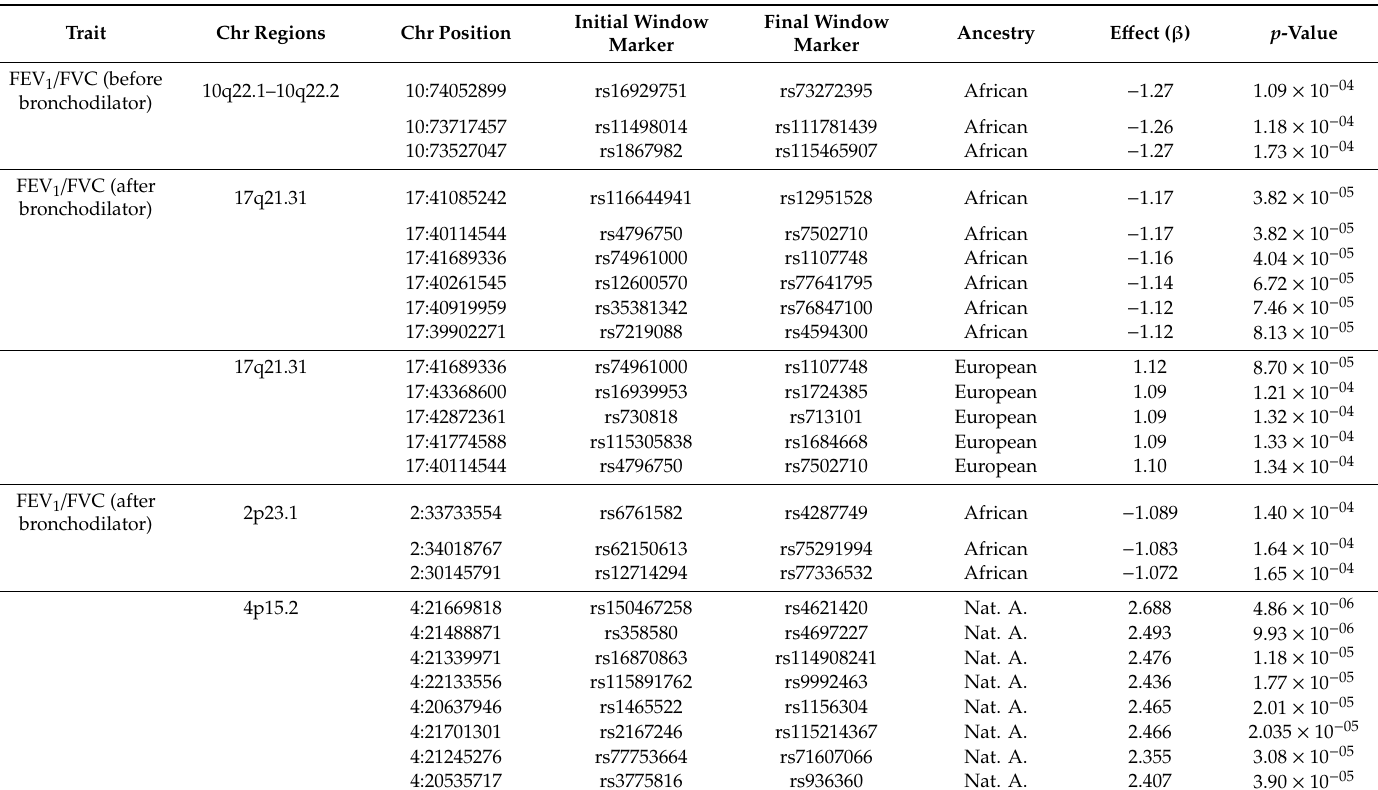
Table 1. Peak regions indicated by admixture mapping for lung function measured by the %forced expiratory volume in the first second (FEV 1 ) / forced vital capacity (FVC) ratio, an indicator of airflow limitation, before and after bronchodilator administration, among children from the Social Change, Asthma, Allergy in Latin America (SCAALA) Cohort in Salvador,